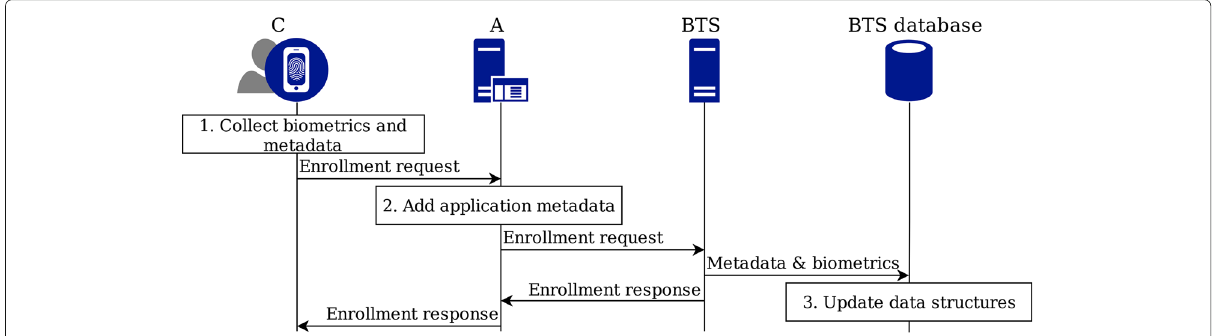
Fig. 1 Illustration of the enrollment